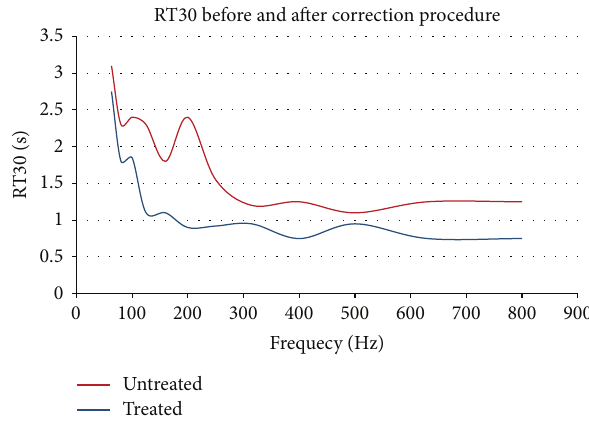
Figure 1: The RT30 of the conference room (a) before and (b) after